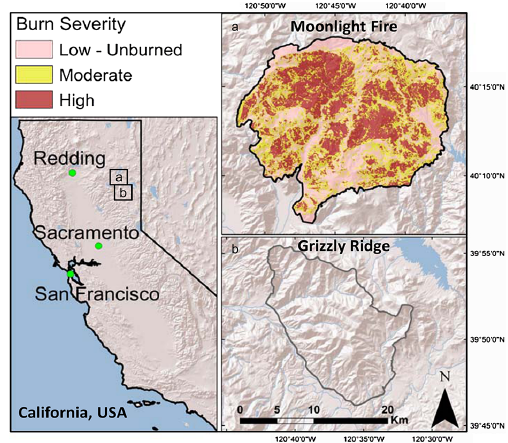
Figure 1. Map of the Moonlight Fire burned area with soil burn severity and control basin Grizzly